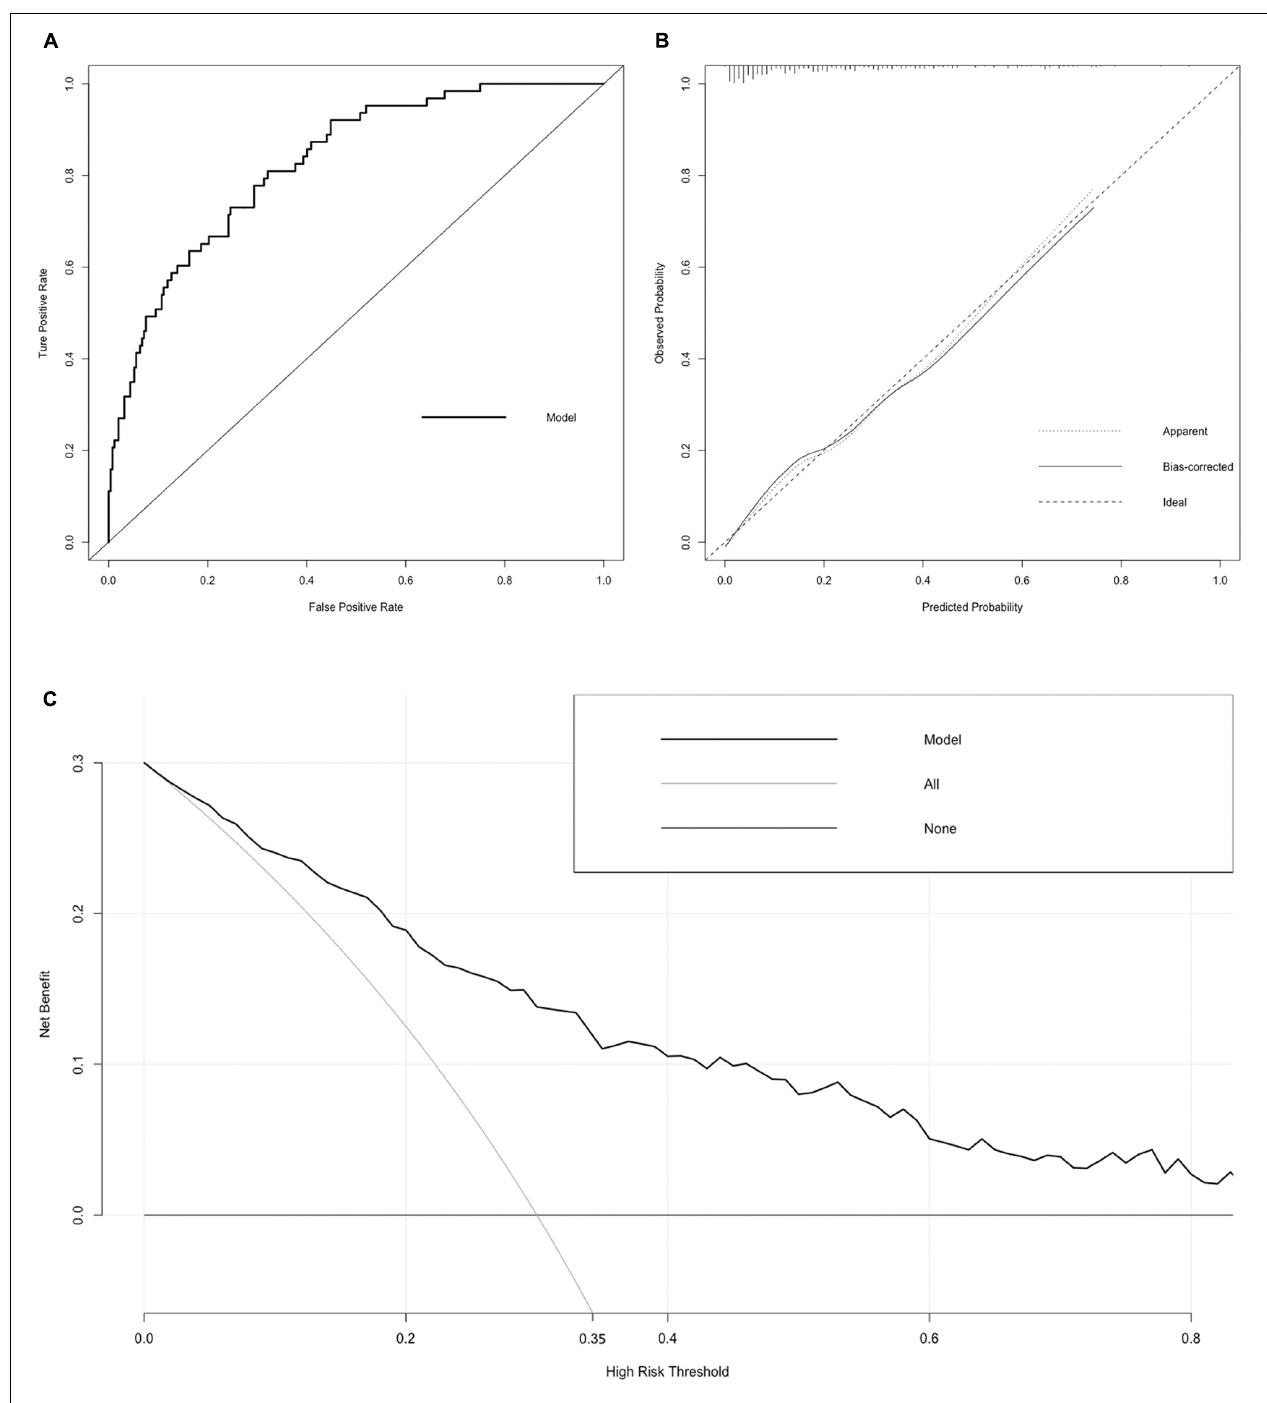
FIGURE 5 | Receiver operating characteristic (ROC) curve, calibration curve, and DCA curve of the nomogram. (A) ROC curve. The AUC of the nomogram was 0.827 (95% CI = 0.774–0.881). (B) Calibration curve. The black dotted line represents the ideal reference line, where the predicted probability matches the observed probability. The solid line is calculated by bootstrapping (resampling: 1,000) and represents the performance of nomogram. The closer the solid line is to the black dotted line, the more accurate the model predicts the incidence of LACR. (C) DCA curve. The dark black dotted line indicates that assuming that all patients do not have LACR, the net benefit rate is 0. The light black dotted line indicates that assuming that LACR occurs in all patients, the net benefit rate is a backslash with a negative slope, and the “high risk” threshold is 0.35. The solid line is the decision curve the nomogram, reflecting the relationship between threshold probability and net benefit. The closer the curve is to the upper right, the greater the net benefit under the same threshold probability. ROC curve, receiver operating characteristic curve; AUC, area under curve; CI, confidence interval; LACR, late-onset acute cellular rejection; DCA, decision curve analysis.